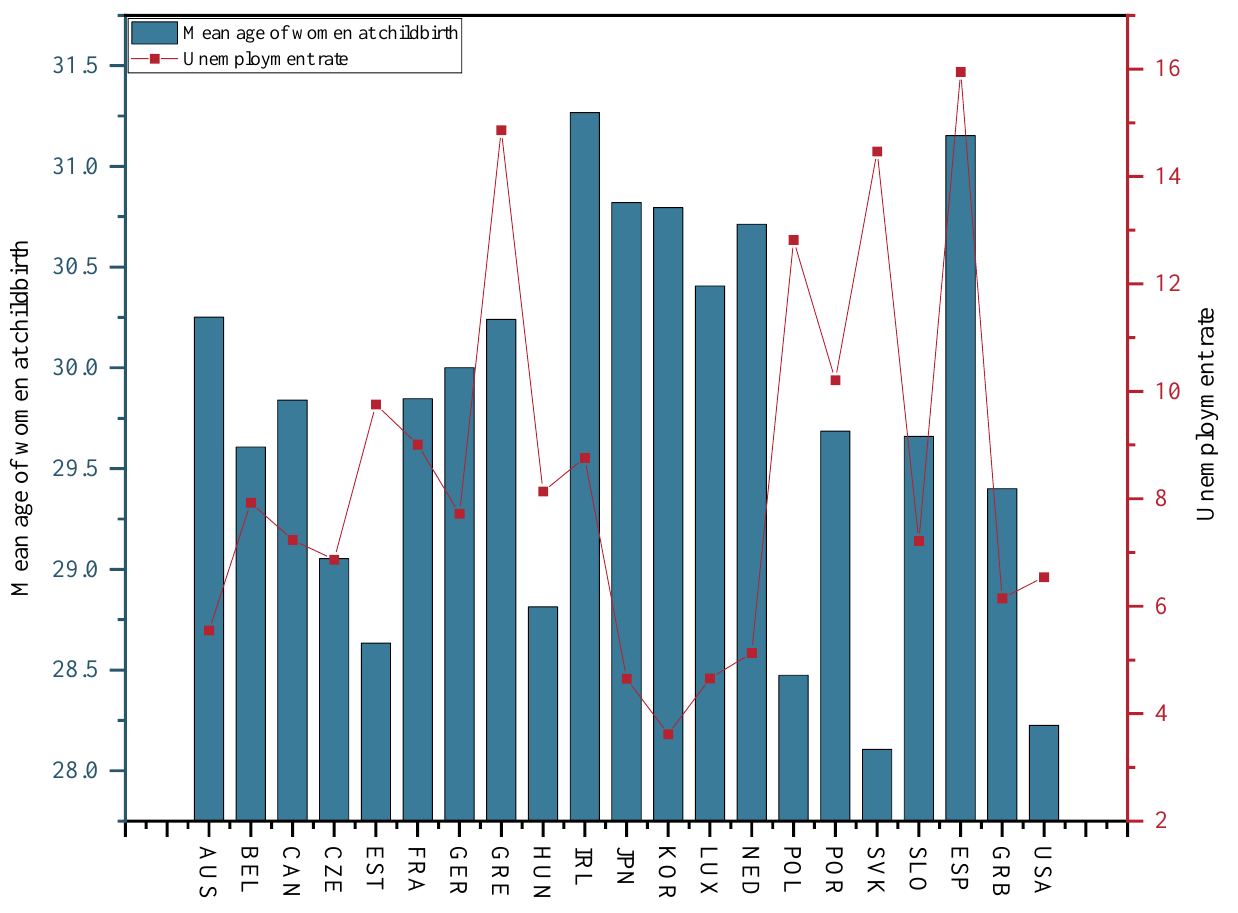
Figure 8. Average unemployment rate in the selected OECD countries, 2001 – 2015. For the mean age of women at childbirth, Figure 8 presents the average age at child- bearing for females in the selected OECD countries between 2001 and 2015. Among the selected OECD countries, Ireland has the oldest female age at childbearing at 31.27, whereas the Slovak Republic achieves the youngest female age at childbearing with an average age at childbearing of 28.11. The above-mentioned data originate from the OECD Household